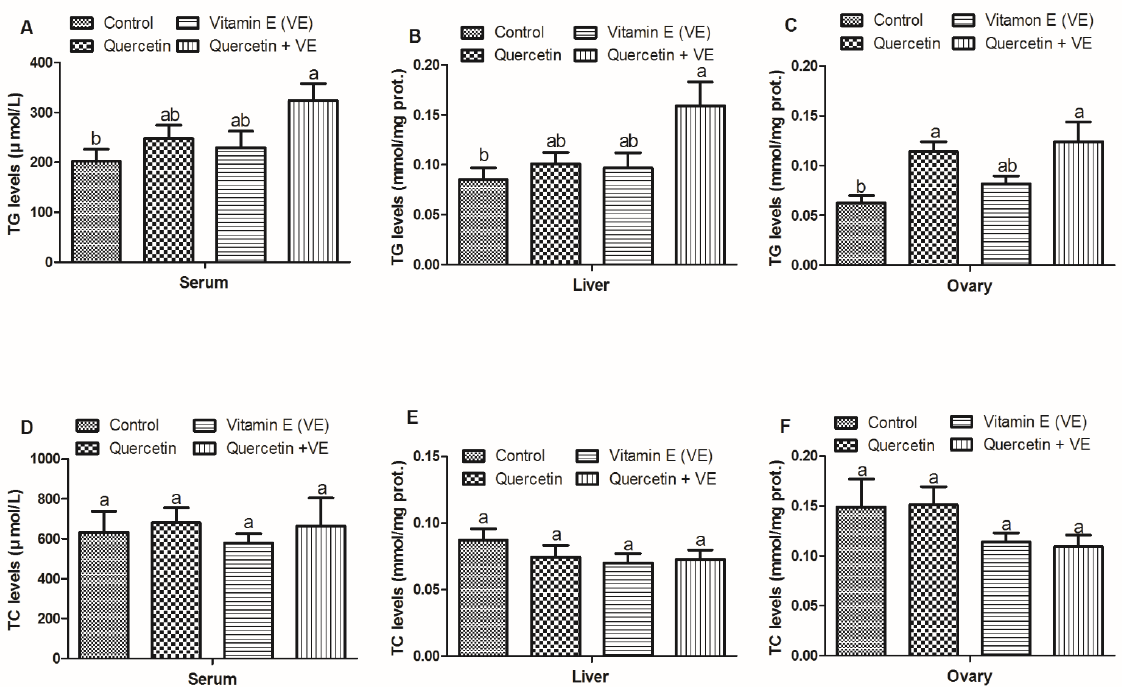
Figure 2. Effects of quercetin, vitamin E, and quercetin + vitamin E on the triglyceride (TG) and total cholesterol (TC) levels in the liver, serum, and ovary of the aging breeder hens. Figure 2: Levels of TG ( A – C ) and TC ( D – F ). The values are presented as the mean ± SD. Bars without the same letter differed significantly ( p < 0.05). prot: protein.